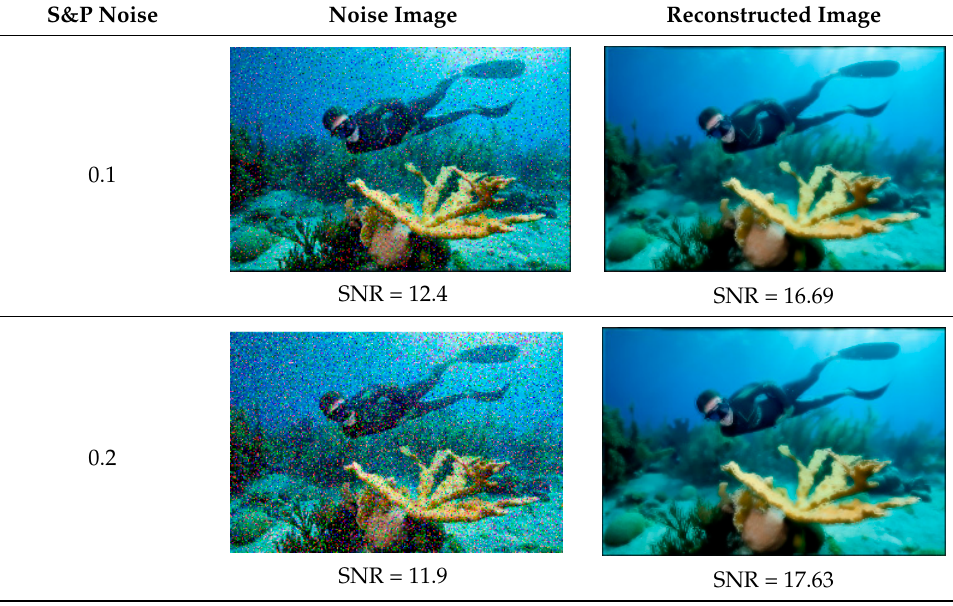
Table 5. SNR Comparison of an Image with Different Intensity of Noise.